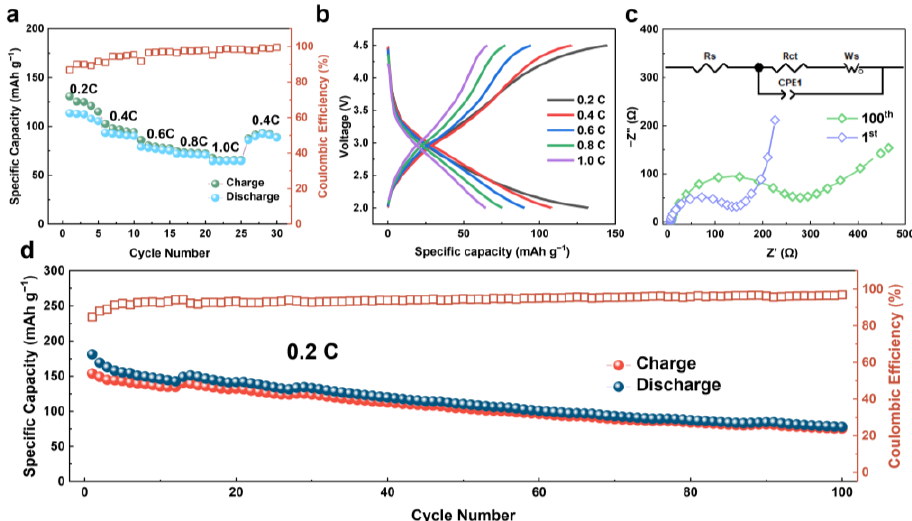
Figure 7. Electrochemical performance of FeF 3 @C-SIBs: ( a ) Discharge/charge capacities at different rates; ( b ) Discharge/charge profiles at corresponding rates; ( c ) Comparison of impedance spectra for 1 and 100 cycles of FeF 3 @C SIBs at open-circuit voltage; ( d ) Long-term cycle stability of the FeF 3 @C cathode at 0.2 C.